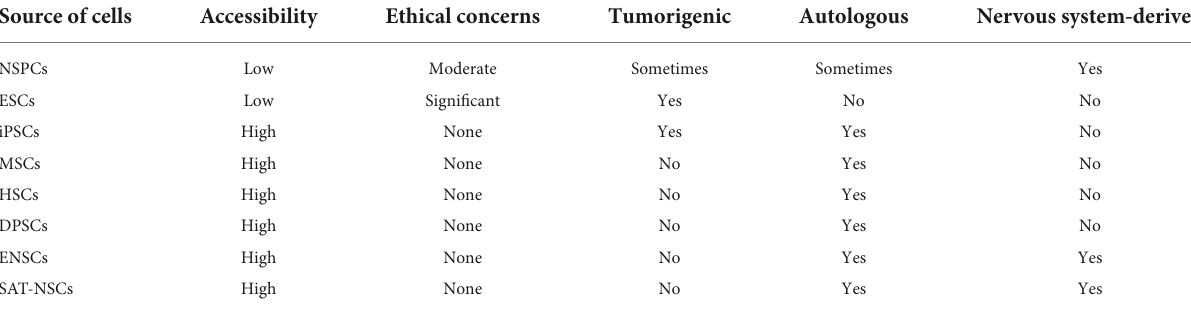
TABLE 1 Cell sources for regenerative central nervous system (CNS) therapy.